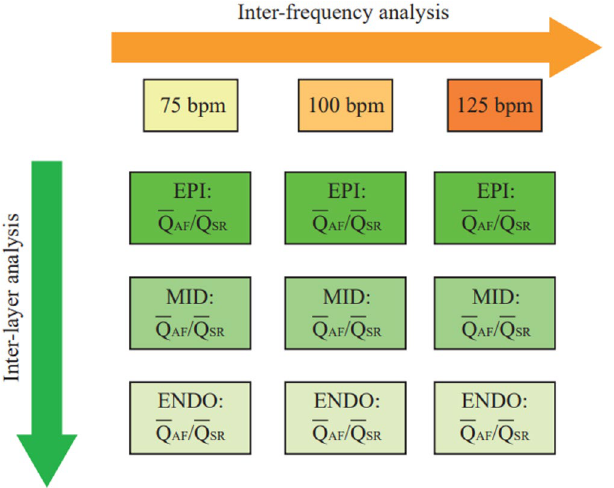
Figure 4. Graphical representation of the two analysis perspectives: (1) inter-layer analysis aims at comparing the Q AF / Q SR ratio, given a specific ventricular rate, across the different myocardial layers (subepicardium, midwall or subendocardium), to assess the differential impact of atrial fibrillation on the perfusion of the different myocardial strata; (2) inter-frequency analysis compares the Q AF / Q SR ratio, given a specific myocardial layer across different simulated ventricular rates, to assess the contribution of ventricular rate to the alteration of the coronary circulation. EPI subepicardium, MID midwall, ENDO